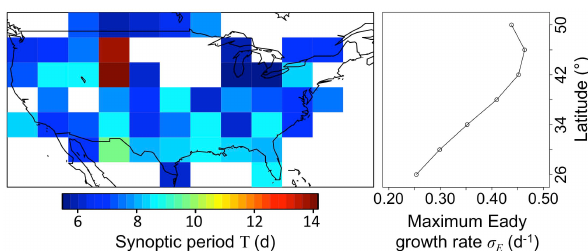
Fig. 3. Mean synoptic periods T of the dominant meteorological modes for interannual PM 2 . 5 variability in NCEP/NCAR Reanal- ysis 1 observations for 1981–2000. Also shown is the latitudinal profile of maximum Eady growth rate σ E as calculated by Eq. (2) for 0–180 ◦ W and